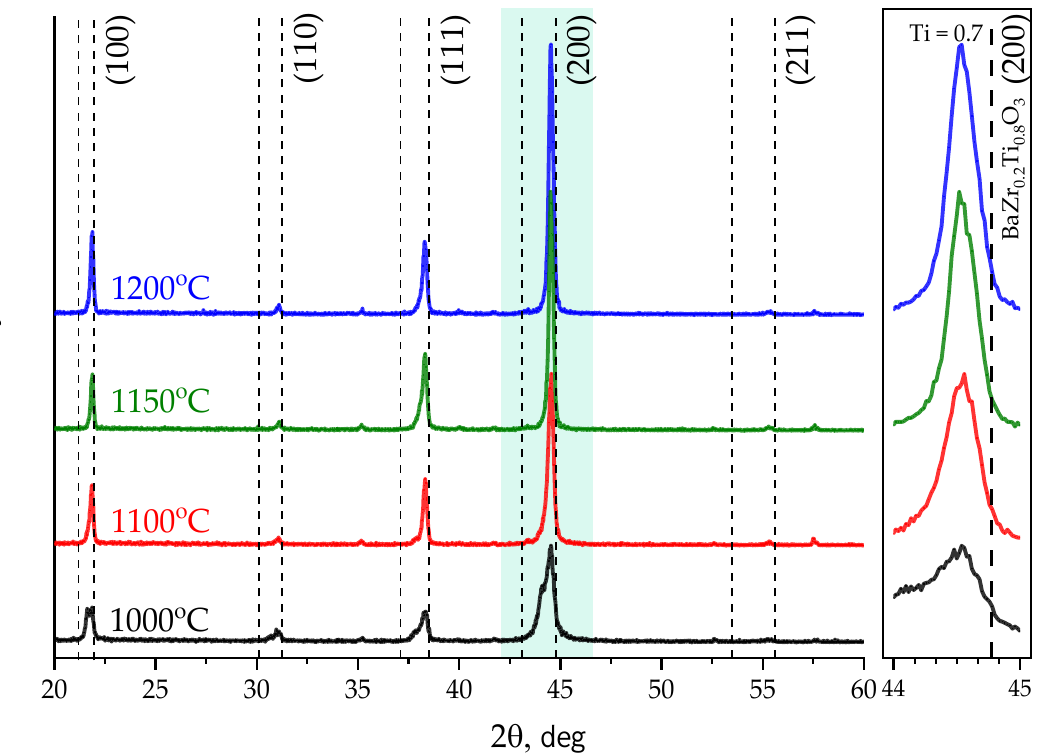
Figure 5. Diffractograms of BZT thin films on Al 2 O 3 substrates deposited in the gas mixture Ar/O 2 :3/1 after annealing at different temperatures.